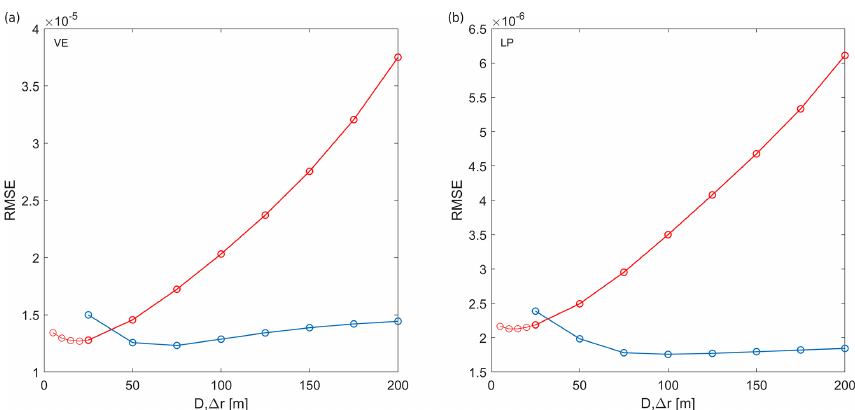
Figure 5. Cumulative residuals over all fibre channels between DAS strain measurements and strain derived from SGM (blue line) and from SIM (red line) for different smoothing parameters (D for SGM and (cid:49) r for SIM, respectively). Computations are performed for the VE (a) and LP (b) events, respectively.